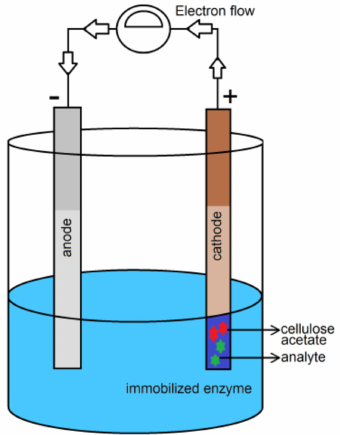
Figure 10. Schematic diagram demonstrating a biosensor testing for the amperometric determination of an analyte based on cellulose immobilized onto the